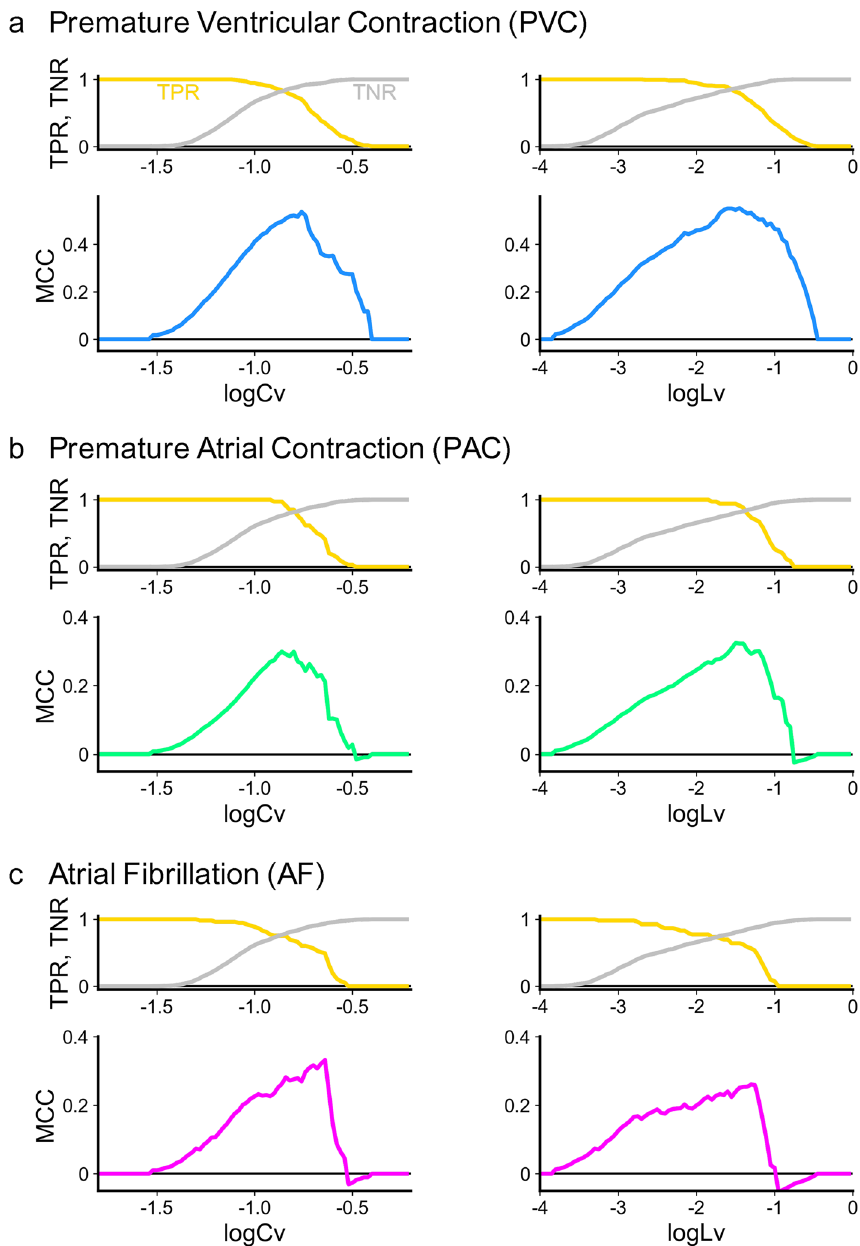
Figure 2. The true positive rate (TPR), true negative rate (TNR), and the Matthews correlation coefficient (MCC) measuring the ability of two individual metrics, thresholds of log 10 Cv and log 10 Lv , to detect cardiac disorders: ( a ) PVC, ( b ) PAC, and ( c ) AF. For each cardiac disorder, each subject was categorized into positive or negative, according to whether the ratio of anomalous states identified by an automatic detection algorithm of ECG was higher or lower than 10%. TPR and TNR indicate the probability of each person being positive and negative according to whether the metric Cv or Lv is higher and lower than a given value, respectively. MCC measures a balance between true and false positives and